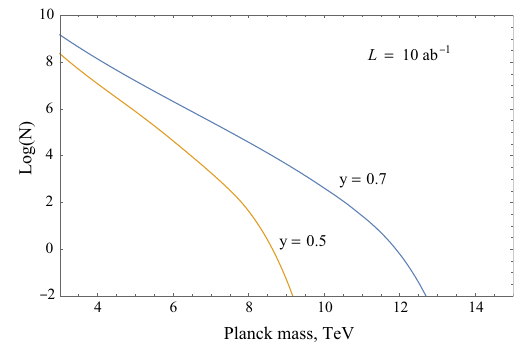
Fig. 2 The number (here and below the logarithmic scale in plots is based on decimal logarithms) of the black holes produced during the lifetime of the future 100 TeV collider with the integrated luminosity L = 10 4 fb − 1 in the theories with D = 6 dimensions, Planck masses 3 − 15 TeV and for two values of the inelasticity parameter y = 0 . 5 and y = 0 . 7